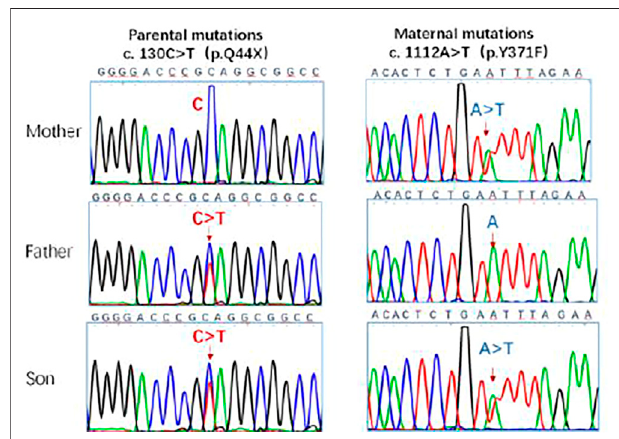
FIGURE4| SangersequencingofENPP1intheparentsandthepatient. The c.130C > T, c.1112A > T locus mutations were detected in the gene. The ENPP1 gene was inherited from both parents with heterozygous c. 130 C > T and c. 1112A > T compound heterozygous mutations. The mutation sites are indicated by the arrows.